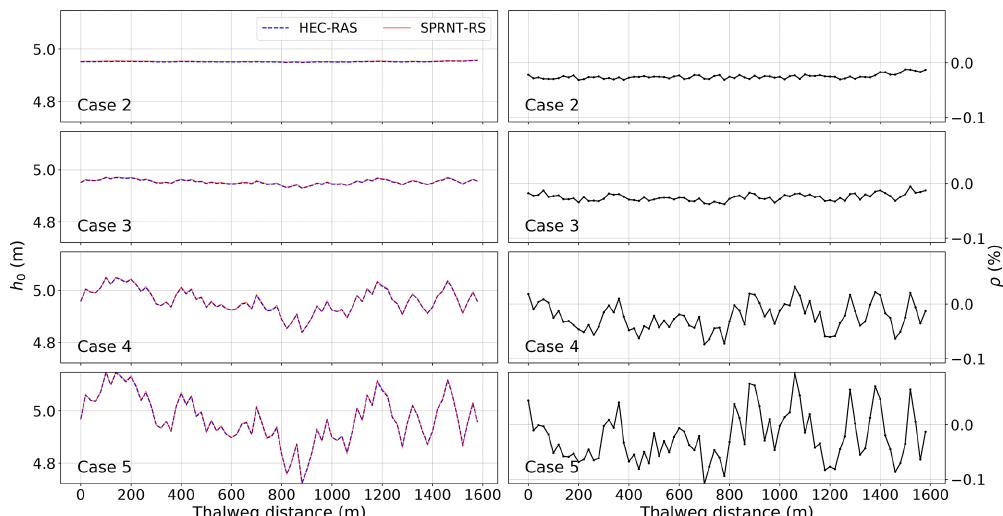
Figure 15. Water depth, h 0 , (left column) and normalized difference, ρ , (right column) for synthetic test cases with perturbed bathymetry.